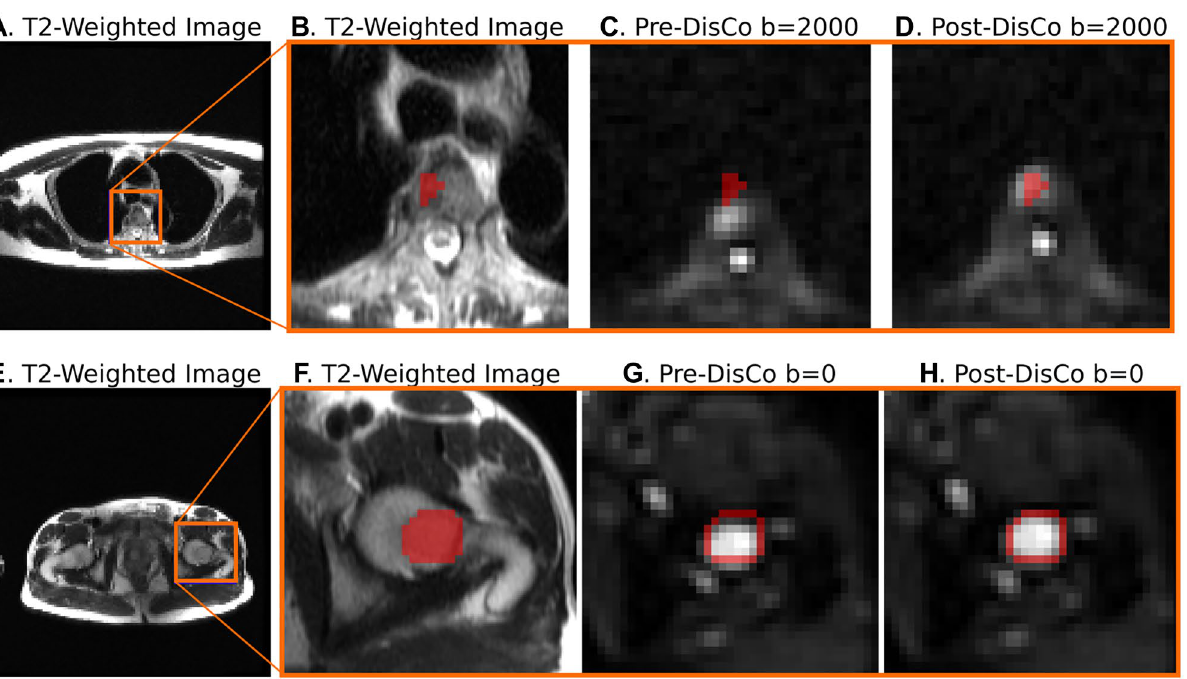
Figure 4. Examples of bone metastases as seen on b = 0 s/mm 2 DWI pre-and post-DisCo. The top row ( A–D ) shows a vertebral lesion in the Thorax Station. The bottom row ( E–H ) shows a lesion within the left femoral head in the Pelvis Station. ( A,E ) T2-weighted images at the corresponding level with an orange bounding box drawn around the lesion. ( B,F ) T2-weighted images zoomed in to visualize lesion and surrounding area. ( C,G ) Zoomed in DWI b = 2000 s/mm 2 and b = 0 s/mm 2 images before DisCo, respectively. ( D,H ) Zoomed in DWI b = 2000 s/mm 2 and b = 0 s/mm 2 images after DisCo, respectively. Outlines of the lesion annotations are overlaid in red. In both examples, the lesions were translated anteriorly following DisCo. Without DisCo, lesion localization may have erred posteriorly. DisCo distortion